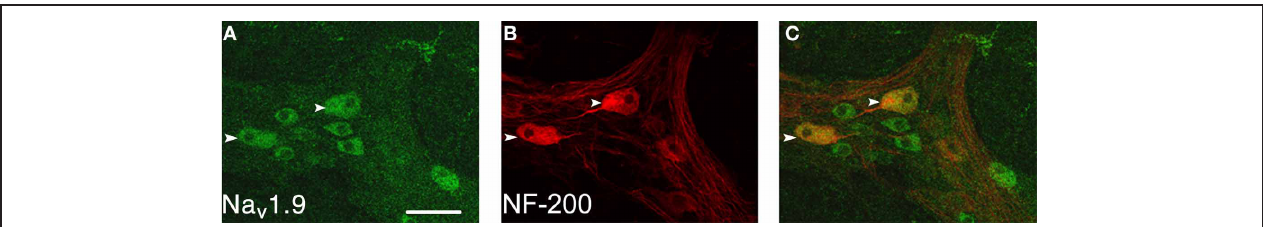
that are NF-200 positive (B) and in smaller NF-200 negative neurons. These two neuron populations are well evidenced on the overlay (C) . Scale bar = 50 µ